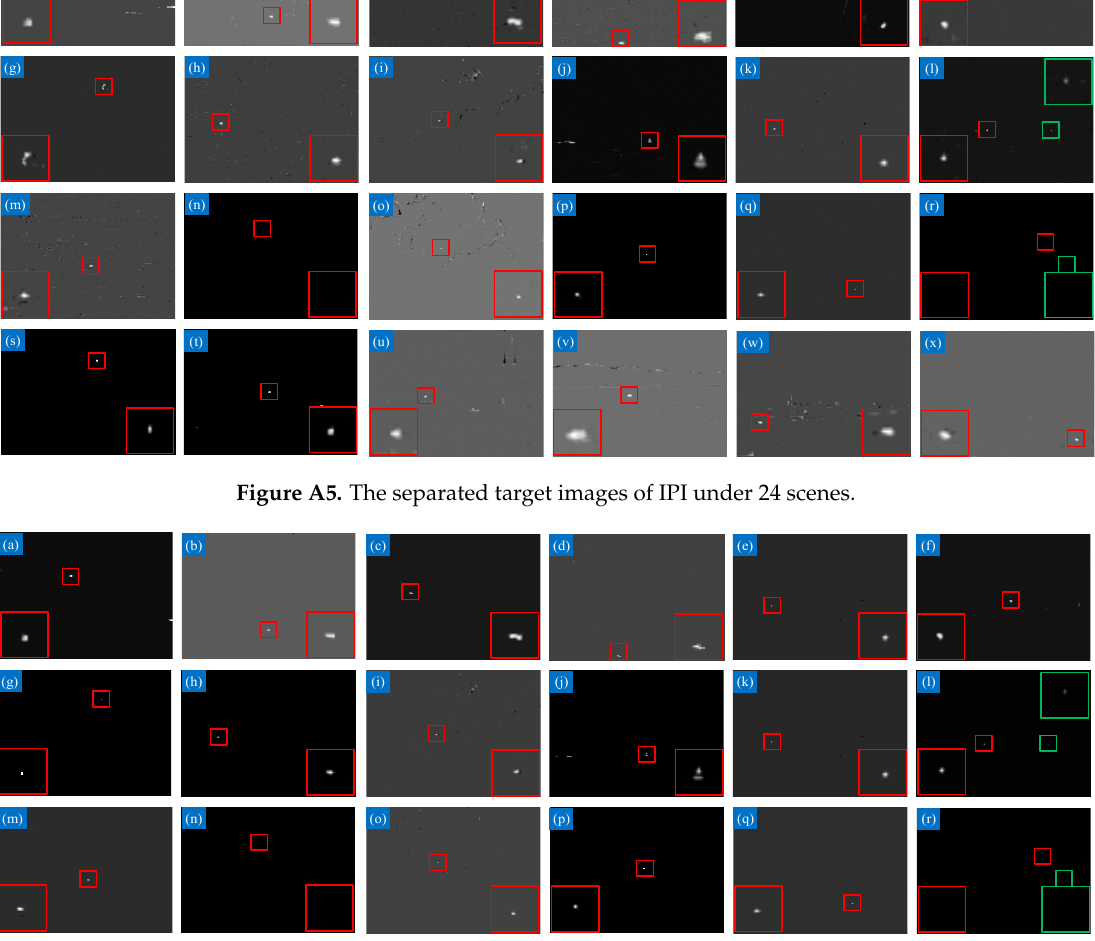
Figure A4. The separated target images of RLCM under 24 scenes.